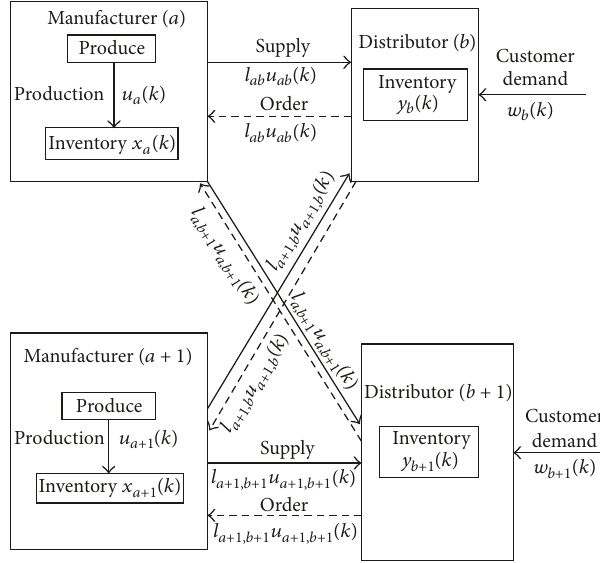
Figure 1: Microstructure of supply chain